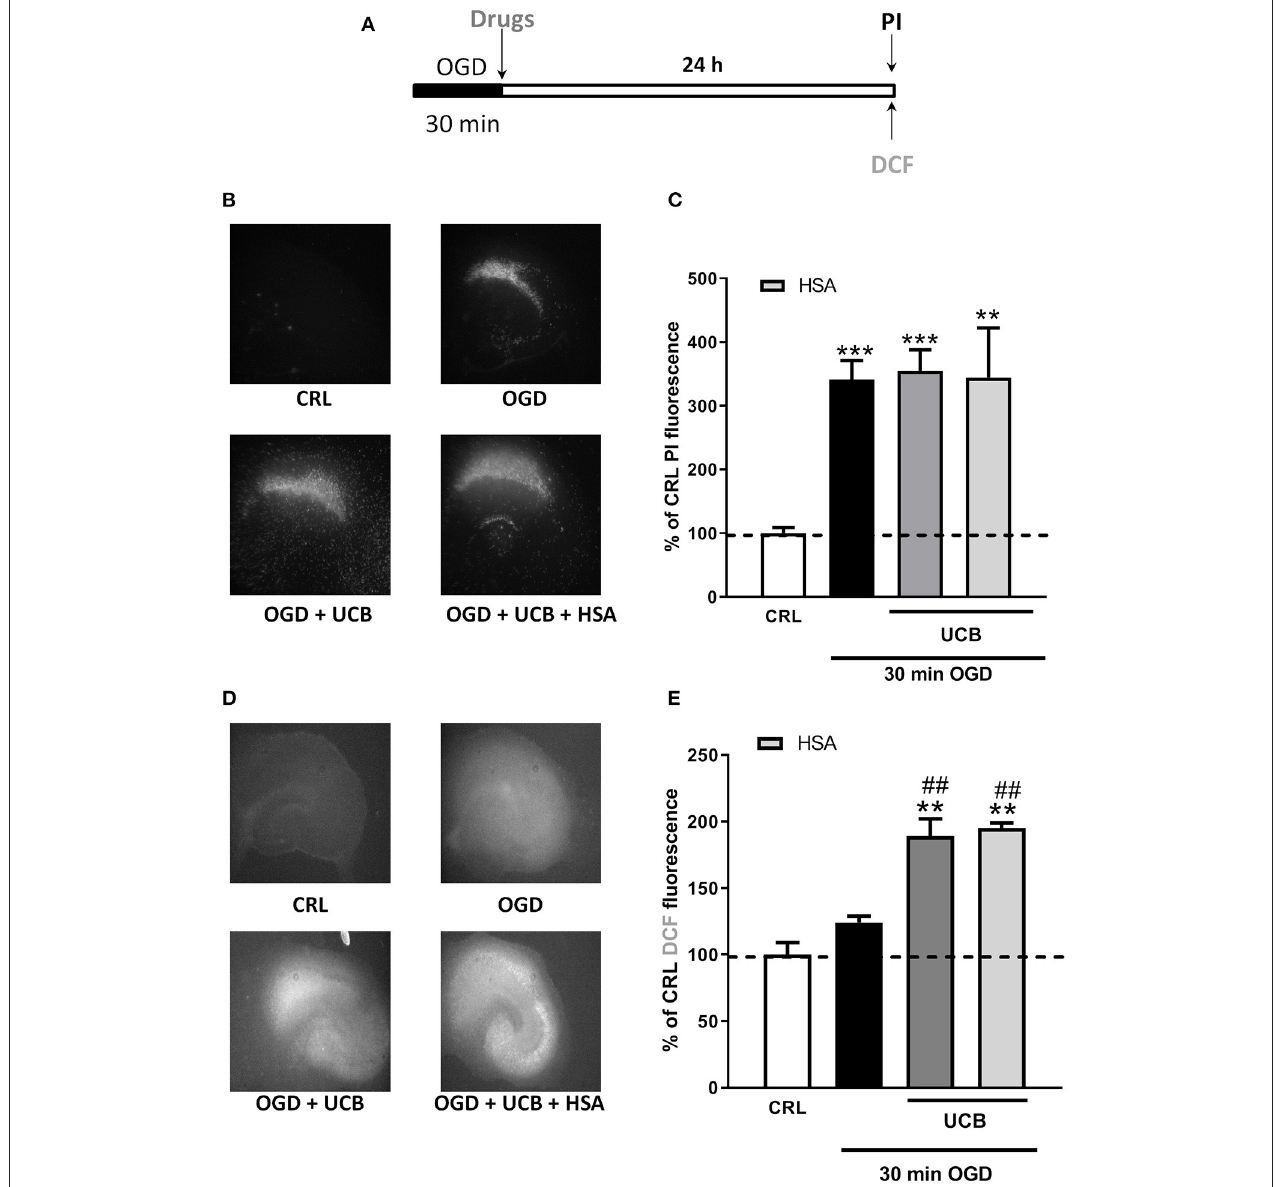
FIGURE 3 | Effects of HSA on UCB-induced-toxicity and ROS production in OGD immature organotypic hippocampal slices. (A) Experimental protocol showing immature hippocampal slices exposed to UCB (100 µ M) alone or plus HSA (100 µ M) for 24h, immediately after 30min OGD. (B) Qualitative analysis shows that CA1 damage induced by OGD is unchanged by UCB and HSA. (C) Quantitative analysis of PI fluorescence: Bars represent the mean ± SEM of at least seven experiments (about ≥ 38 slices for each experimental point). ** P < 0.01 vs. CRL; *** P < 0.001 vs. CRL. (D) Qualitative analysis shows that OGD did not induce oxidative stress, while the addition of UCB (100 µ M) increases ROS production that is unchanged by HSA. (E) Quantitative analysis of DCFH2-DA fluorescence: Bars represent the mean ± SEM of at least seven experiments (about ≥ 24 slices for each experimental point). ** P < 0.01 vs. CRL; ## P < 0.01 vs.